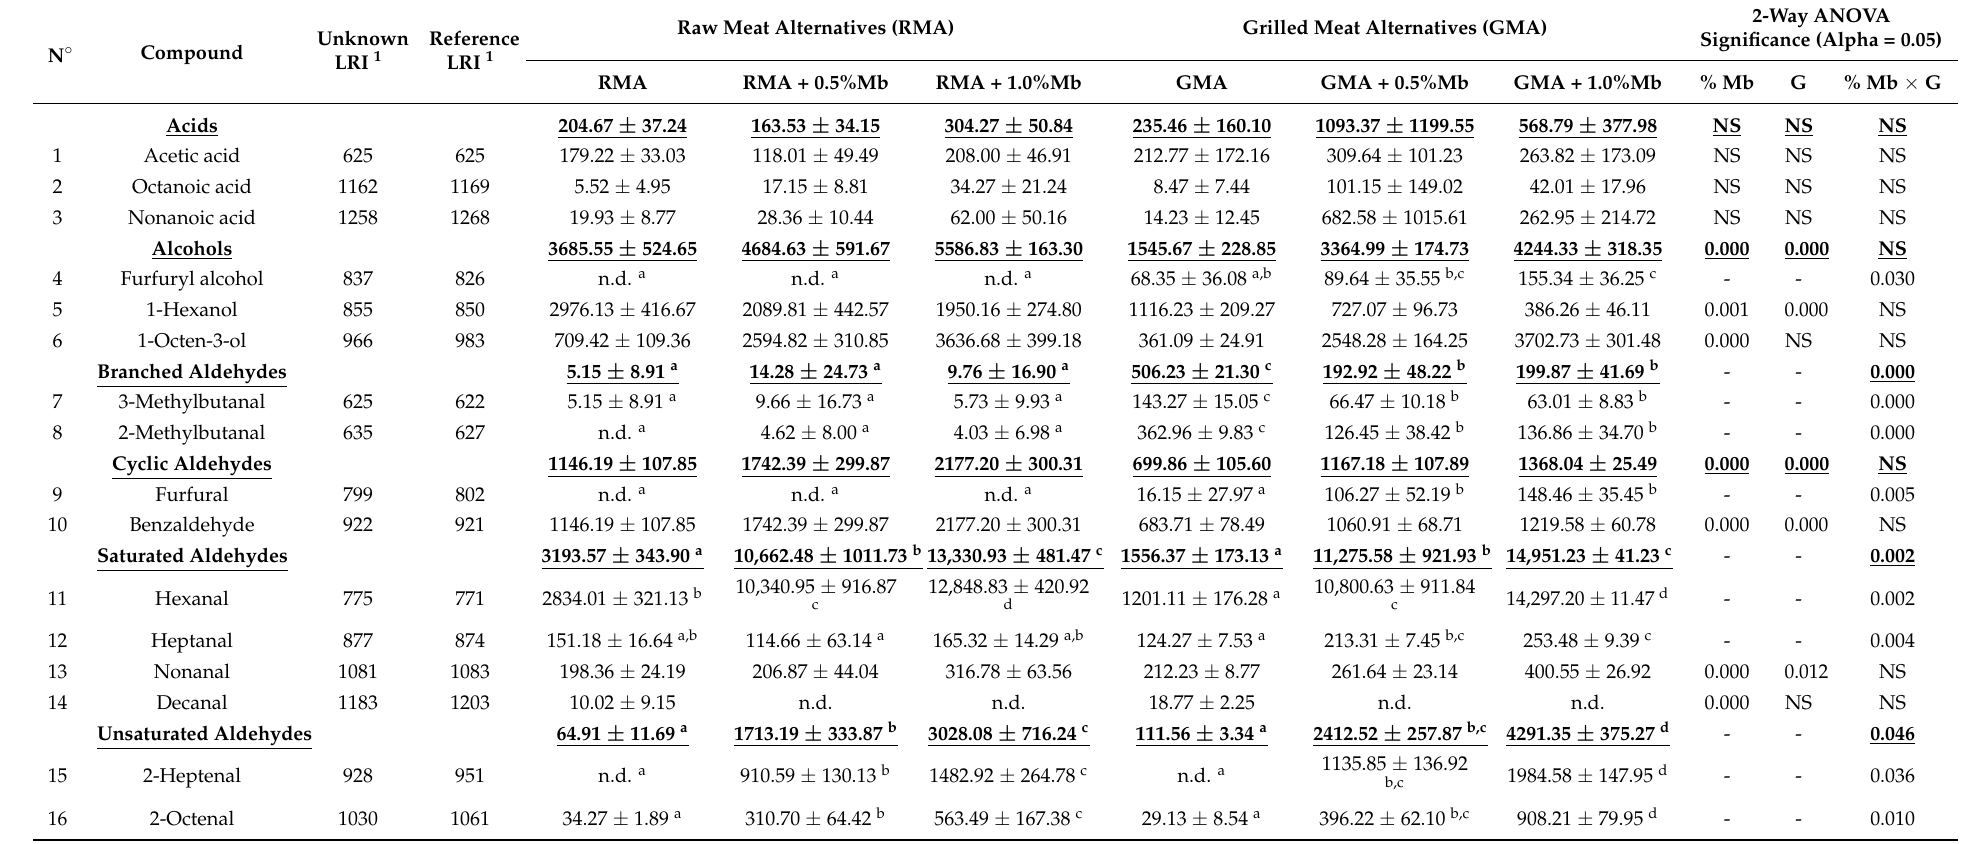
Table 1. Peak areas of volatiles components (average AU × 10 3 ± standard deviation × 10 3 , n = 3) identified in raw and grilled meat alternatives enriched with varying concentrations of commercial myoglobin (Mb). Significance of main effects of % Mb, grilling (G) and their interaction (% Mb × G) following two-way ANOVA analysis are indicated (NS = not significant). In case the interaction term was found to have a significant effect, Tukey’s HSD test was conducted instead of two-way ANOVA of the main effects (- = not analyzed), in which case values within the same row not sharing the same subscript were found significantly different between treatments at p <